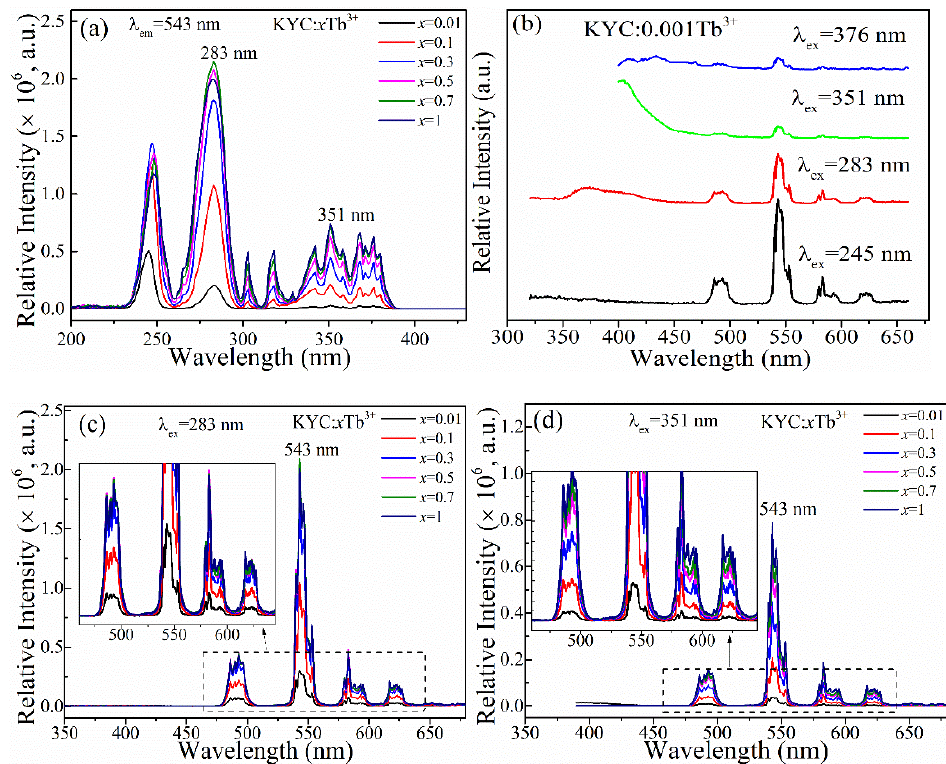
Figure 3. Luminescence spectra of KYC: x Tb 3+ : ( a ) excitation spectra; ( b ) emission spectra of KYC:0.001Tb 3+ ; ( c ) emission spectra excited at 283 nm; ( d ) emission spectra excited at 351 nm.